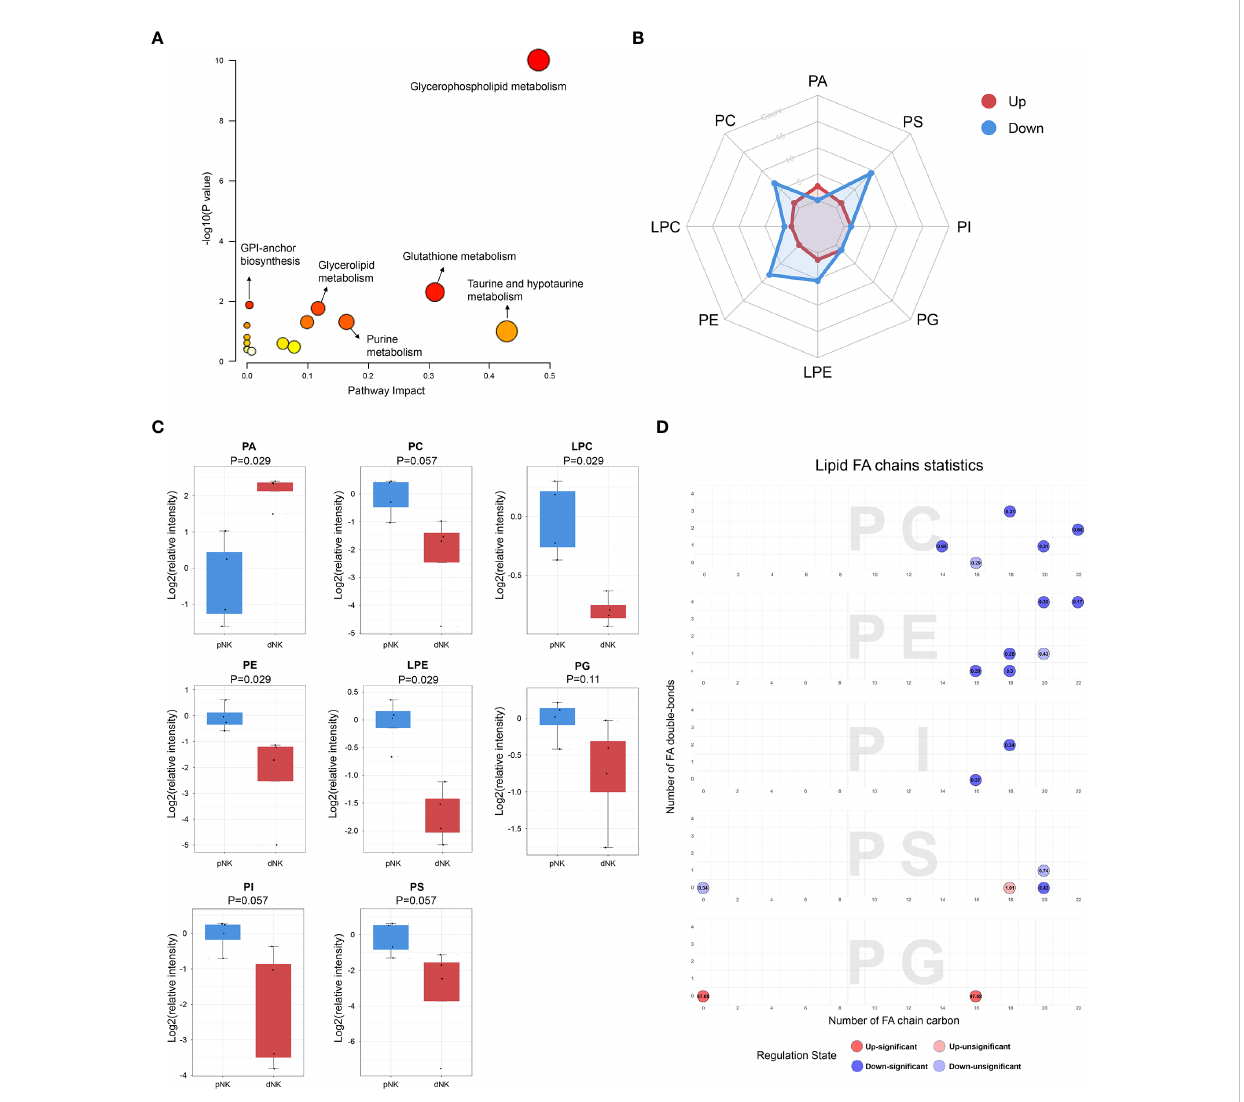
FIGURE 3 Metabolic pathways change in dNK cells compared to pNK cells. (A) KEGG metabolic pathway impact analysis using Metaboanalyst 5.0. (B) Radar diagram of subclasses in glycerophospholipids. (C) Relative intensity of glycerophospholipid related metabolites in dNK and pNK cells. Statistical analyses were performed using the Mann – Whitney U-test. The box plots show the median and 25 th and 75 th percentiles, with whiskers indicating maximal and minimal values. (D) Lipid fatty acid (FA) chain statistics of glycerophospholipid subclasses. The x-axis presents the number of FA double-bonds and the y-axis presents the number of FA chain carbon. Fold changes are labeled in the circle. The FA chain analysis was conducted using